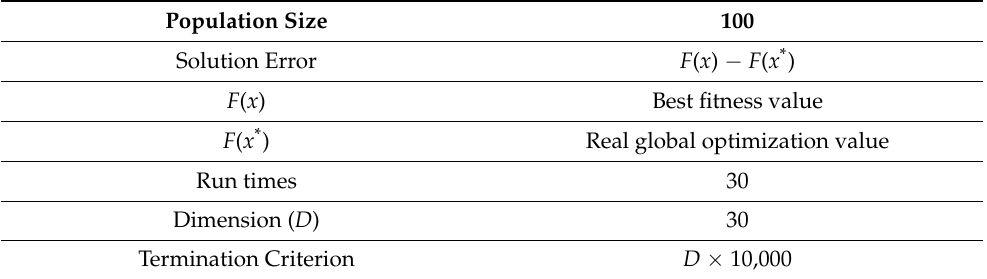
Table 1. Details of experimental parameters.